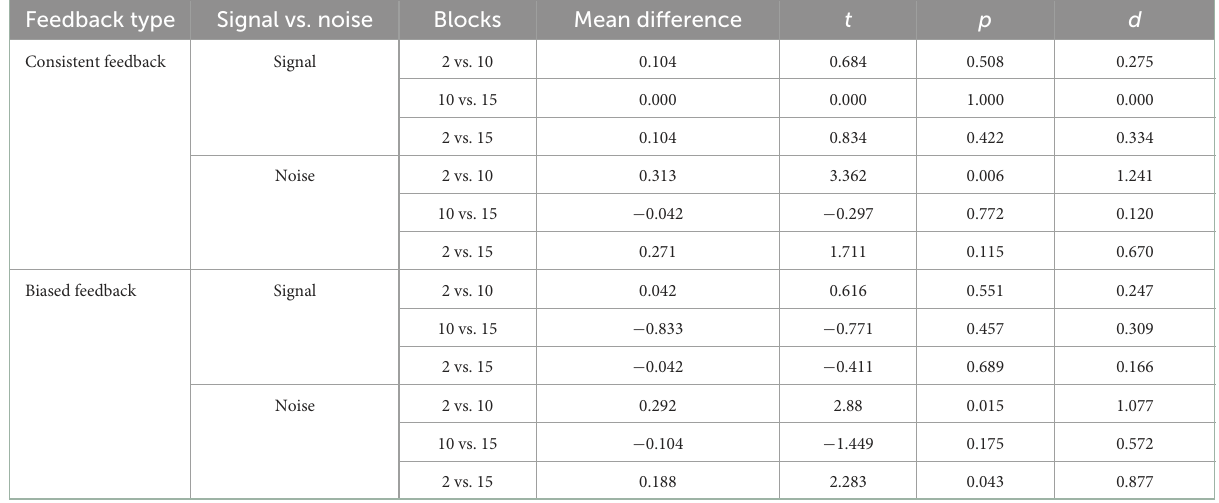
TABLE 4 T -tests of signals and